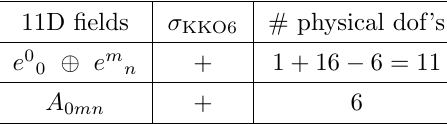
Table 27 . Counting of the total 17 propagating scalar dof’s allowed by KKO6 sources in M-theory compacti(cid:12)cations down to six dimensions. This is exactly the dimension of the supergravity coset given in (3.1), once we subtract from e m n the 6 unphysical directions corresponding to the compact SO(4) generators.